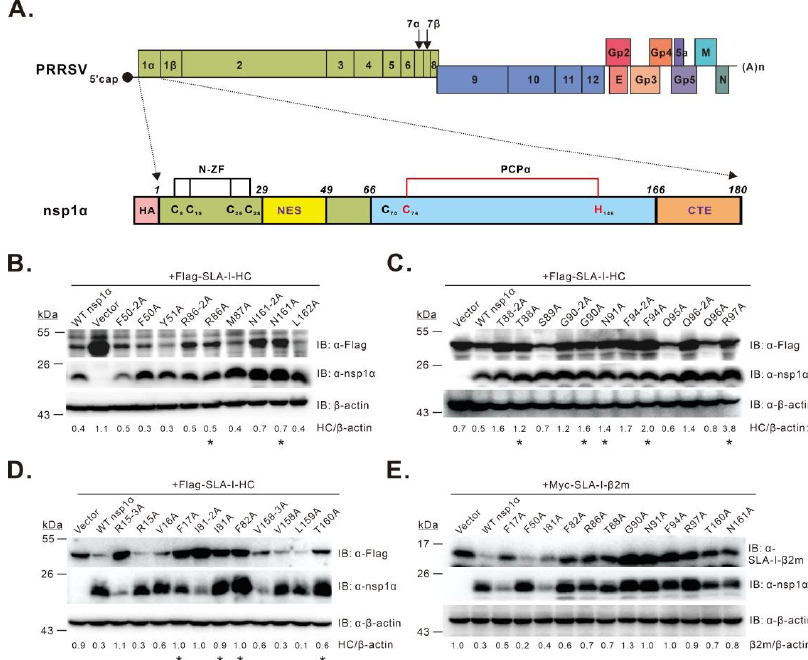
Figure 1. Identification of residues critical for PRRSV nsp1 α -mediated degradation of SLA-I. ( A ) structure organization of the PRRSV genome and nsp1 α ; ( B – E ) screening of nsp1 α residues nec- essary for SLA-I degradation by co-transfection assay. HEK 293T cells were transfected to express FLAG-SLA-I-HC ( B – D ) or Myc- β 2m ( E ) in combination with HA-nsp1 α or its mutants. At 36 h post-transfection, the cells were subject to Western blot analysis with antibodies to FLAG, SLA-I- β 2m, nsp1 α , or β -actin. Asterisk (*) indicates the mutants that were selected for further analysis. The data are representative of results from three independent experiments. The relative abundance of SLA-I was normalized against β -actin, and the ratio is shown at the bottom of the